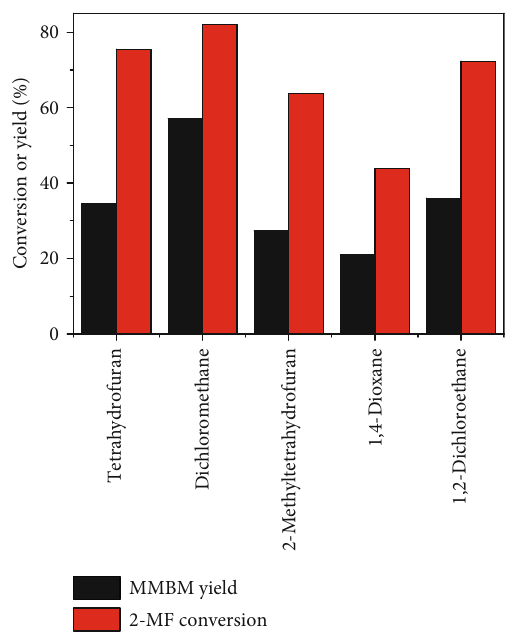
Figure 7: The in fl uence of the solvent type on the synthesis of MMBM from HMF and 2-MF. Reaction conditions: 3 mmol 2- MF, 1mmol HMF, 2mL solvent, 100 ° C, and 8 h.